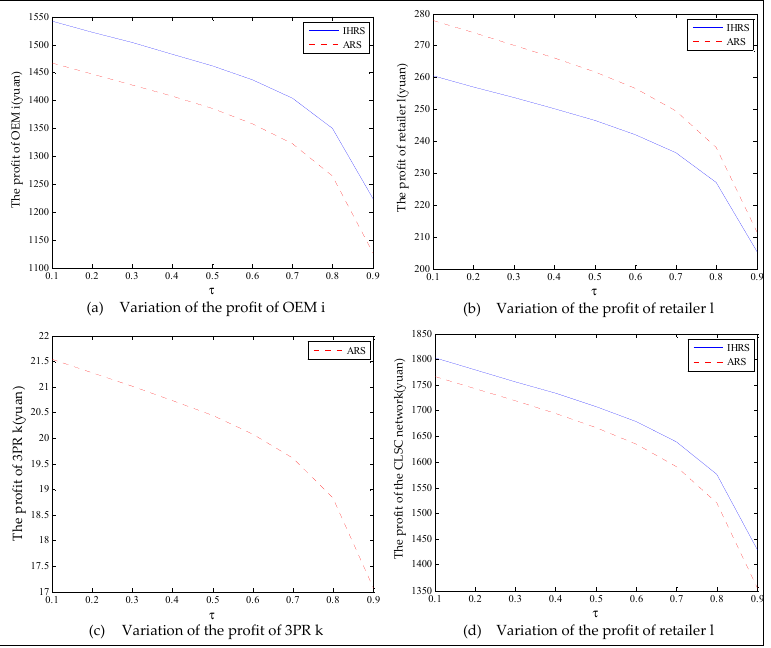
Figure 21. The variation of the profits in Case 1 of Section 6.3.